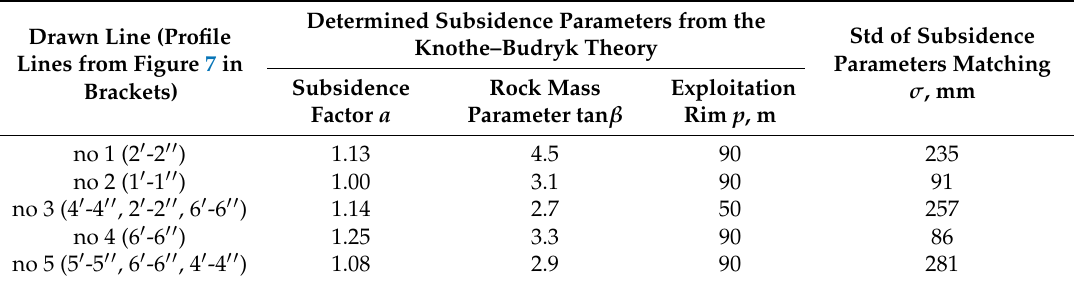
Std of Subsidence Parameters Matching σ , mmSubsidence